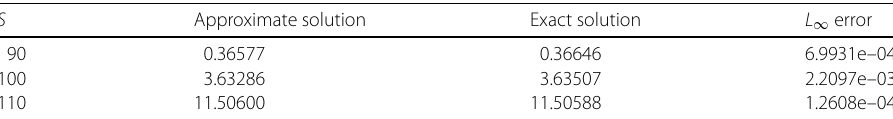
Table 1 A comparison between the approximate solution and the exact solution corresponding to the European call options under the Merton model with λ = 0 S Approximate solution